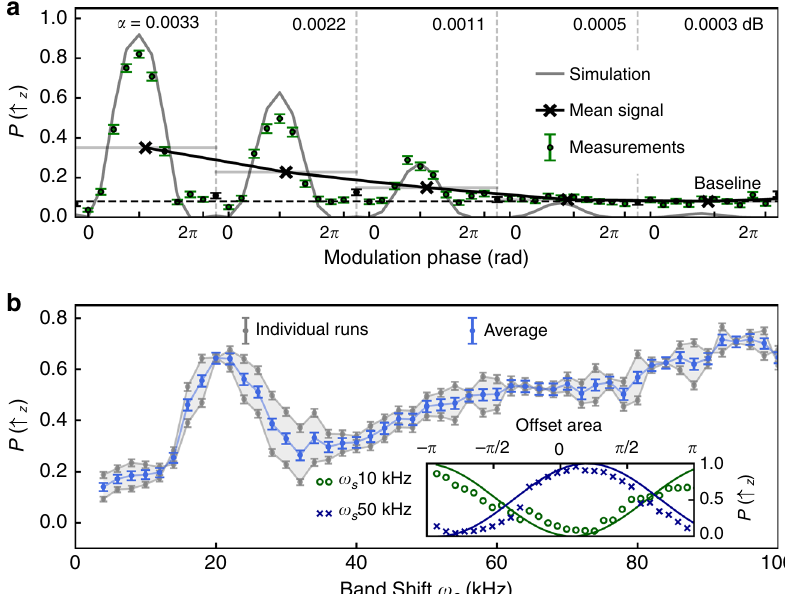
Fig. 4 Sensing experiments of intrinsic amplitude noise using a single ion. a Sensitivity calibration using k = 0 and ω sid = ω s , with ω s = 10 kHz. Measurements are taken for linearly sampled phases from 0 to 2 π with varying modulation depth and interleaved noiseless pulses to identify the fi delity limits of the experiments ( “ Baseline ” ). Each measurement is repeated 200 times; the resulting projection noise is captured by the error bars. The overall signal is represented as the average over all phase realizations. b Frequency-dependent amplitude instability probed with band-shifted k = 0 DPSS- modulated pulses. The measurement is repeated twice by scanning the ω s fi rst from 2 – 100 kHz and then from 100 – 2 kHz. The bandwidth of the DPSS fi lter (FWHM) is ~150 Hz. (inset) A small offset pulse is added at the beginning of the main protocol and its area is varied over the range [ − π , π ] to demonstrate the frequency-dependent pulse offset behavior. High-contrast fringes indicate quantum coherence is